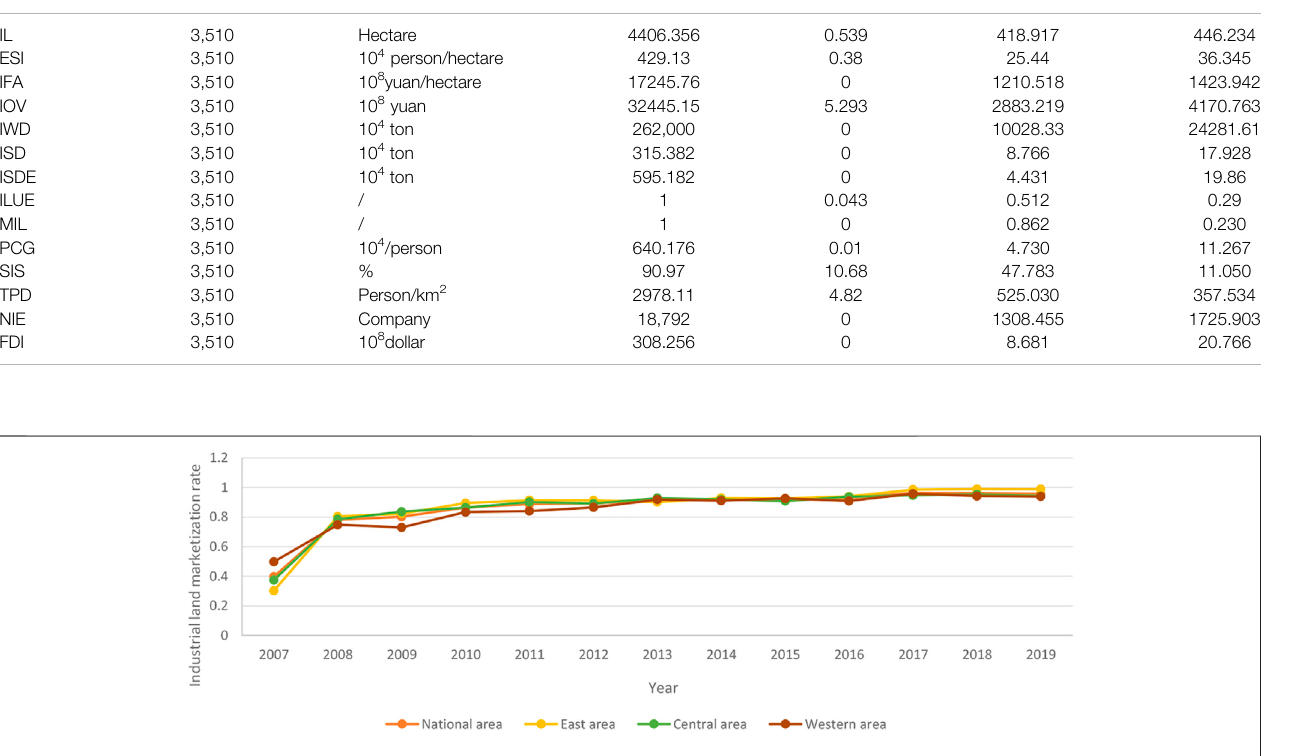
FIGURE 4 | Changes in the MIL in the three major areas of China.